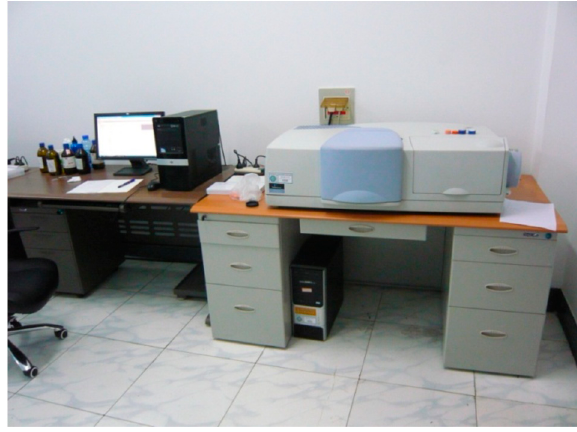
Figure 4. UV / VI / IR Spectrophotometer. Figure 4. UV/VI/IR Spectrophotometer. Figure 4. UV/VI/IR Spectrophotometer.